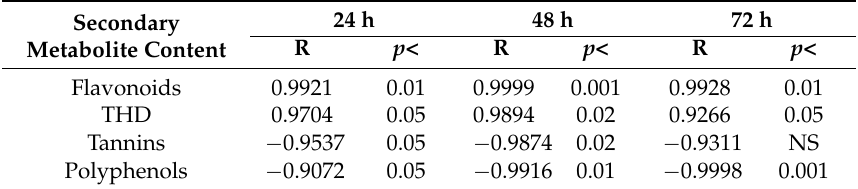
Table 3. Correlation coefficients (R) and statistical signifficance ( p <) for the relationship between max. effect (% of cell survival) and the content of secondary metabolites.